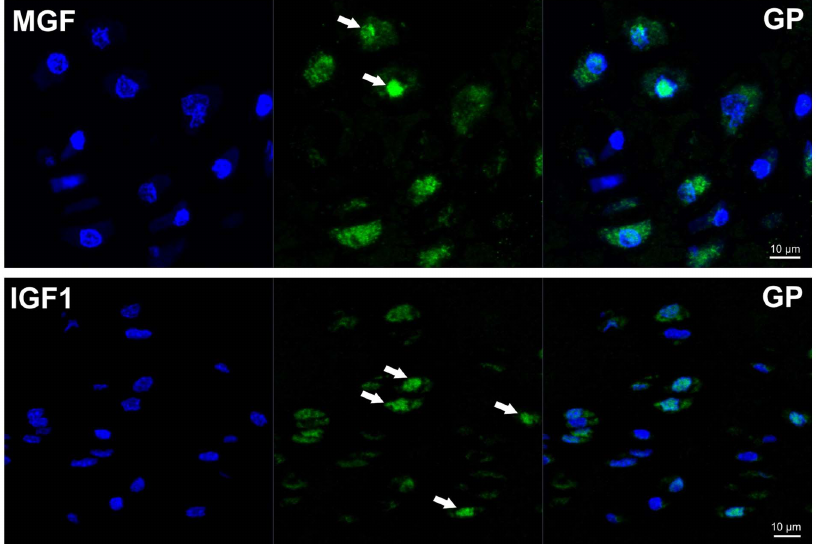
Figure 5. Immunofluorescent staining of GP cartilage (rz) for MGF and IGF1 shows co-localisation of green signal (white arrows) with DAPI stained nuclei (blue) in few cells. Some cells are negative for MGF as well as IGF1.